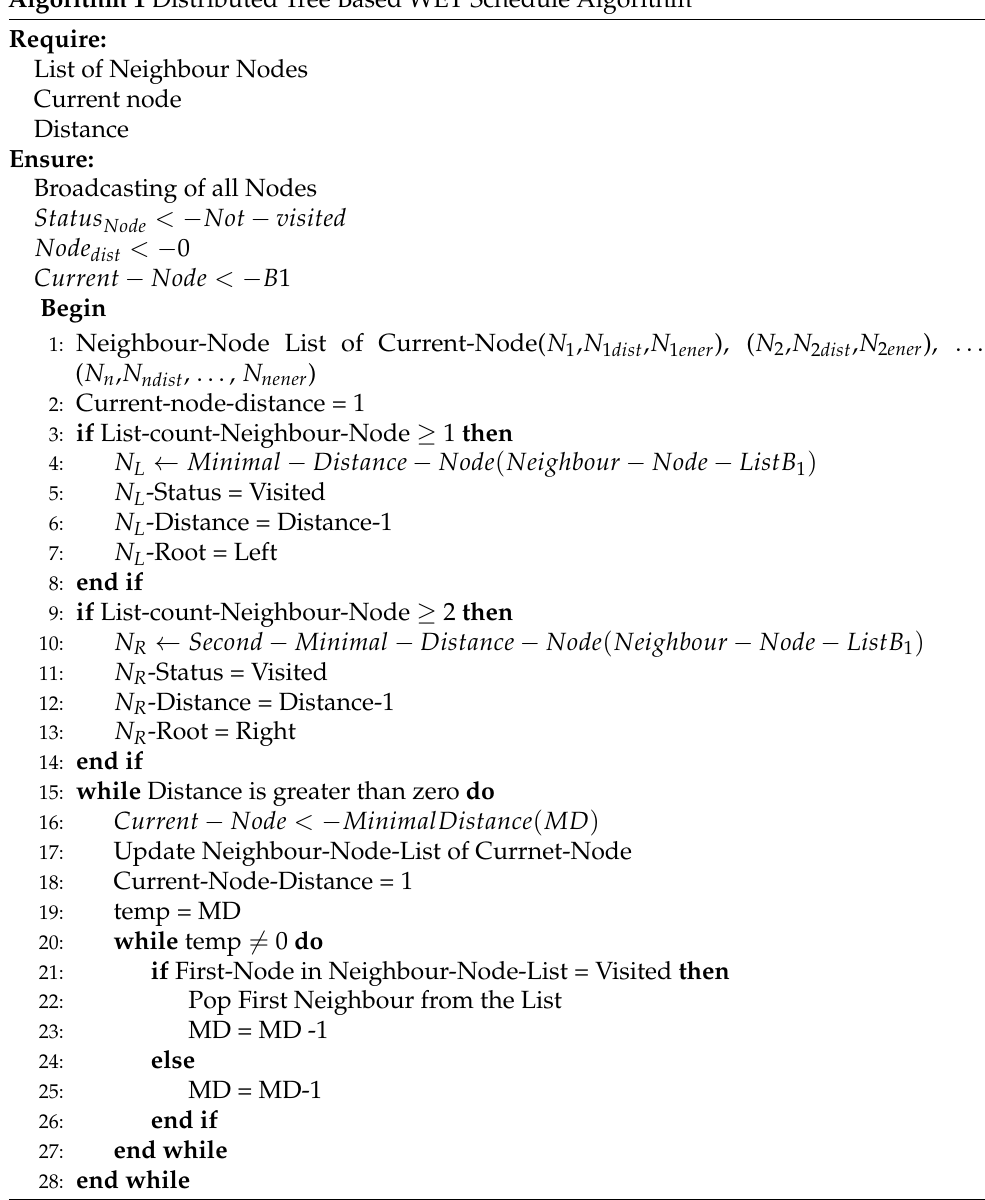
Algorithm 1 Distributed Tree Based WET Schedule Algorithm